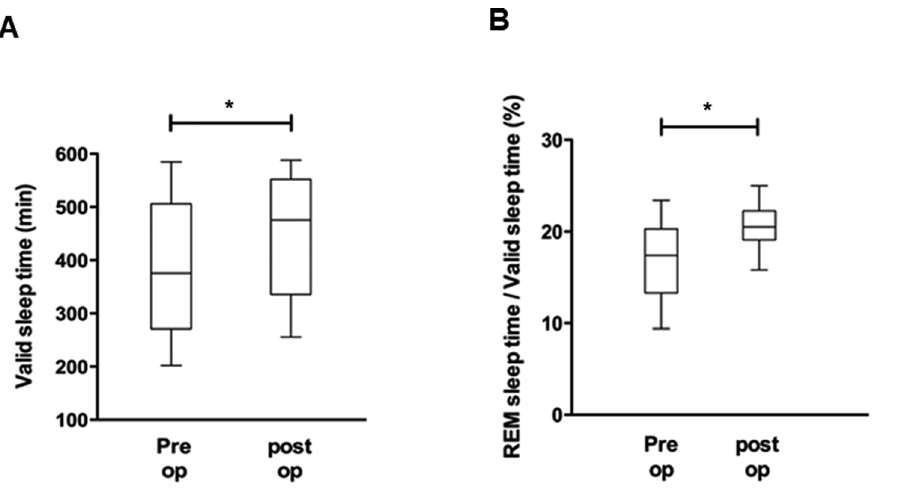
Figure 4. Changes in watch-PAT-derived factors, such as valid sleep time (A) and percentage of REM sleep (B), before and after nasal surgery. * : p , 0.05 when comparing the pre-and post-operative